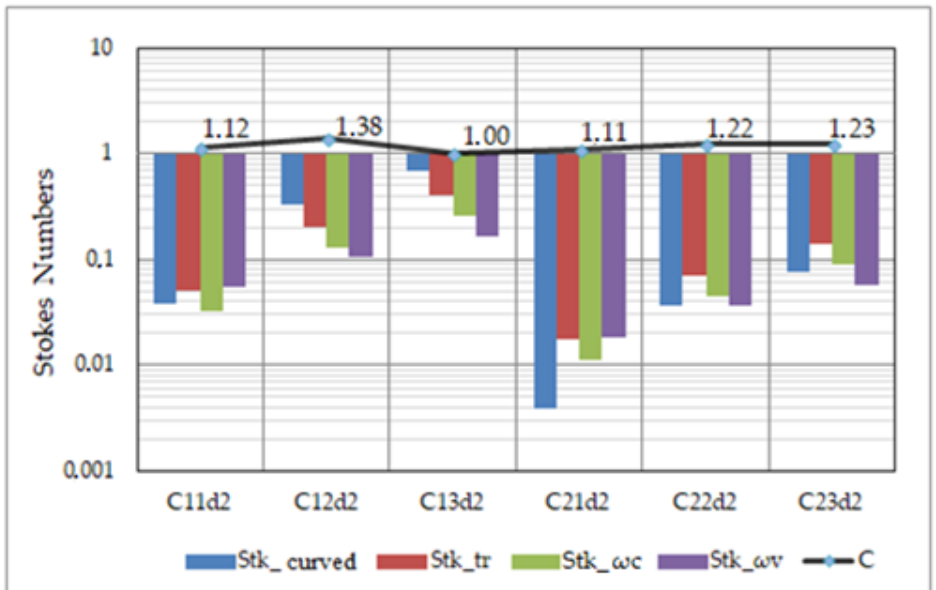
Figure 13. Bar graph of the Stokes numbers and trend line of relative concentrations between cases, for particle sizes d2 = 150 [μm].